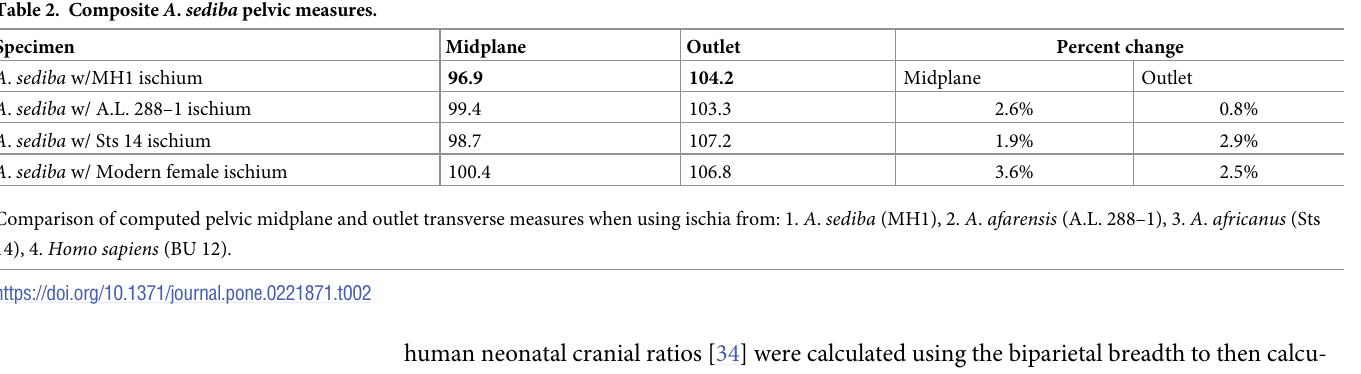
(cid:0) � (cid:0) � (cid:0) � p � BP � 1 : 22 BP � 0 : 65 BP ) (see 3 2 2 2